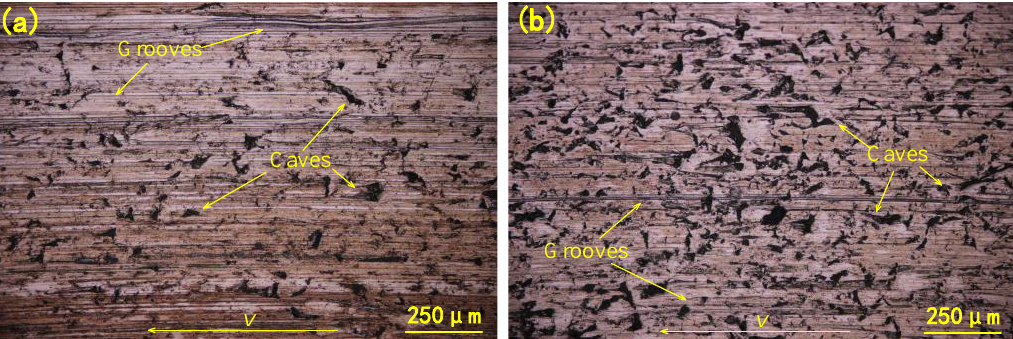
Figure 7. Wear surfaces of metal disc of ( a ) untreated specimens and ( b ) treated specimens.